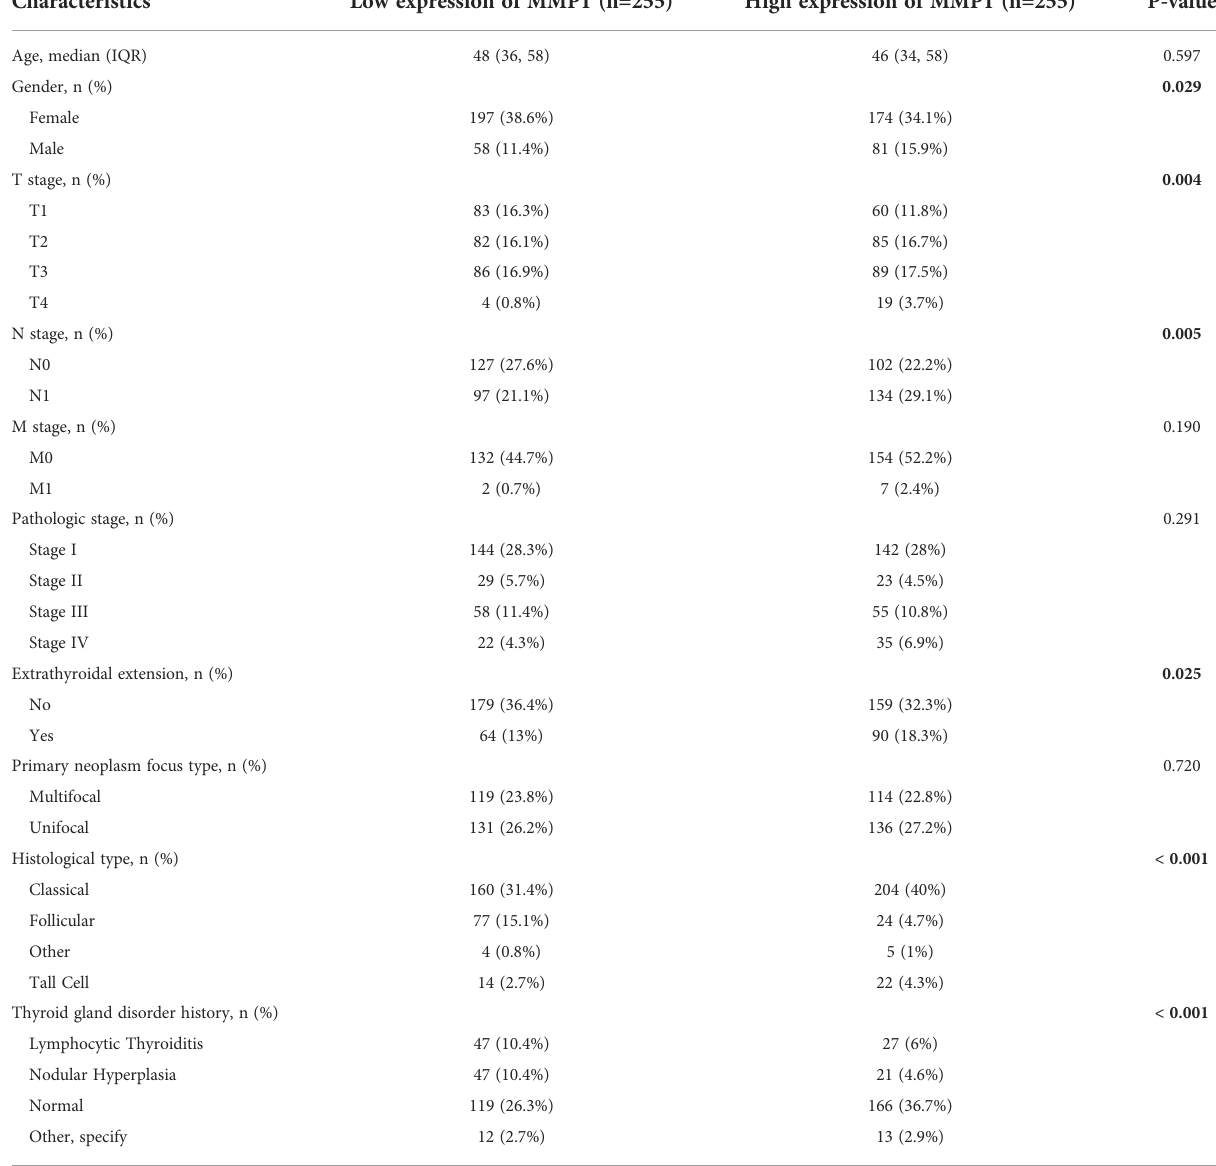
TABLE 1 Clinical characteristics of PTC patients from TCGA database according to MMP1 low or high